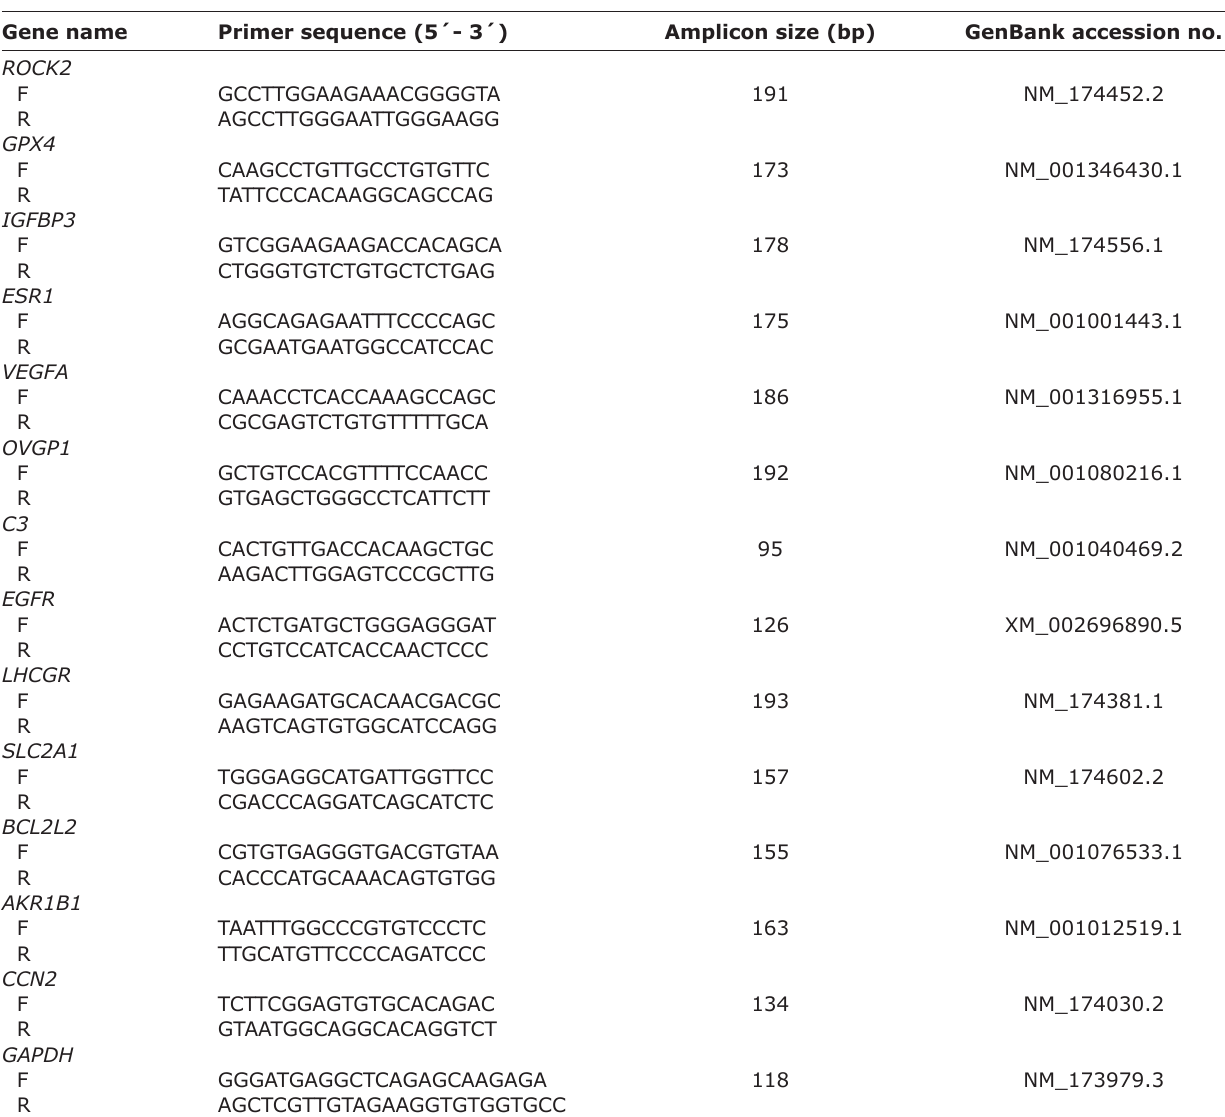
Table-1: Sequence of primers used for qPCR. Gene